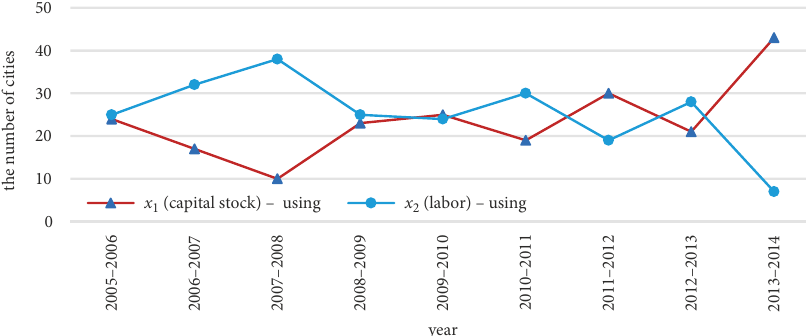
Figure 7. Input biased technological changes of capital stock ( x 1 ) and labor ( x 2 )